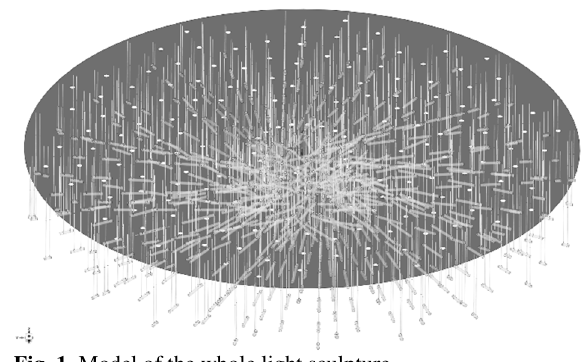
Fig. 1. Model of the whole light sculpture.